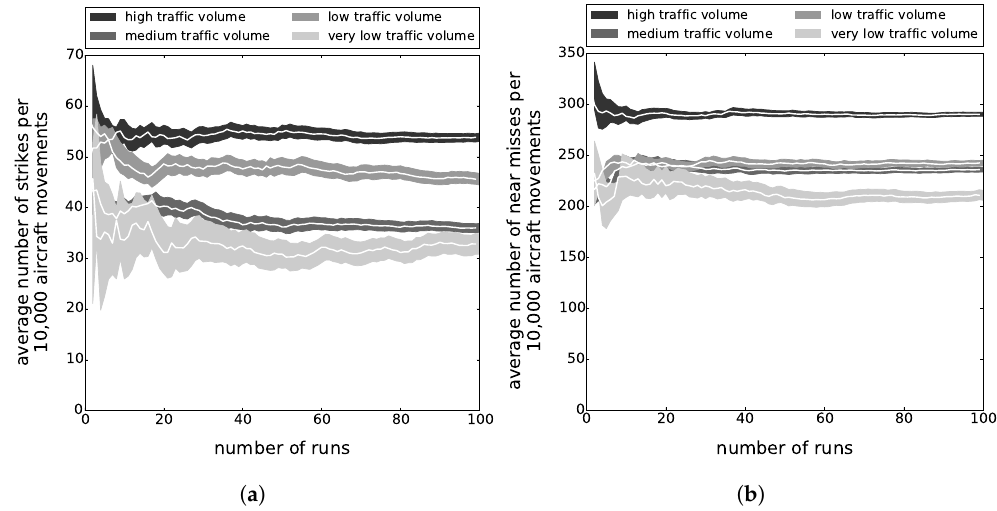
Figure 4. Convergence of average number of bird strikes and near misses over all simulation runs. White lines represent the average numbers, colored areas the standard error. ( a ) Bird strikes; ( b ) Near misses.